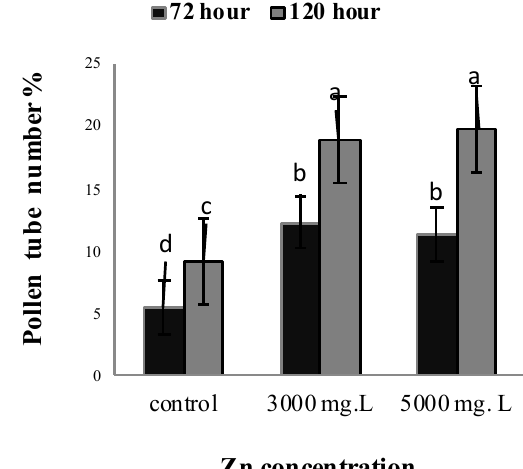
Fig. 8. The interactions between time and Zn concentration on the pollen tube penetration percentage on the middle part of style. Means in each column, followed by similar letter (s) are not signifi- cantly different at 1% probability